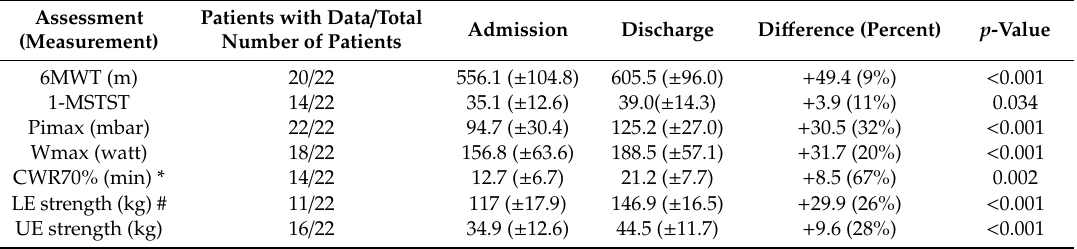
Table 2. Exercise parameters at admission to and reassessment at completion of pulmonary rehabilitation † .